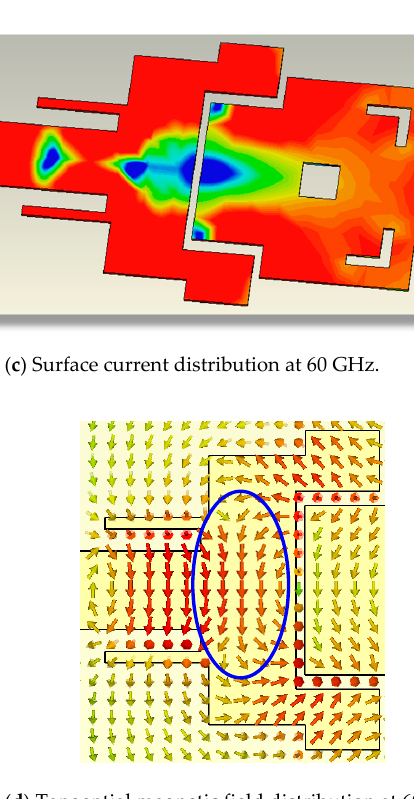
Figure 8. Simulated surface current, tangential magnetic field distributions, and the corresponding radiation patterns of the proposed dual-band patch antenna at 38 GHz and 60 GHz .